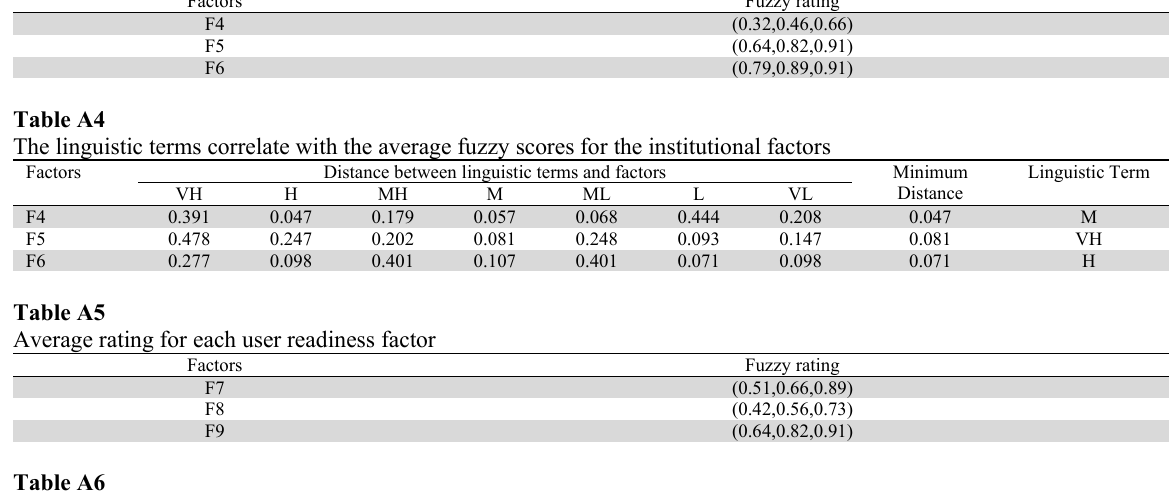
The linguistic terms correlate with the average fuzzy scores for the user readiness factors Factors Distance between linguistic terms and factors